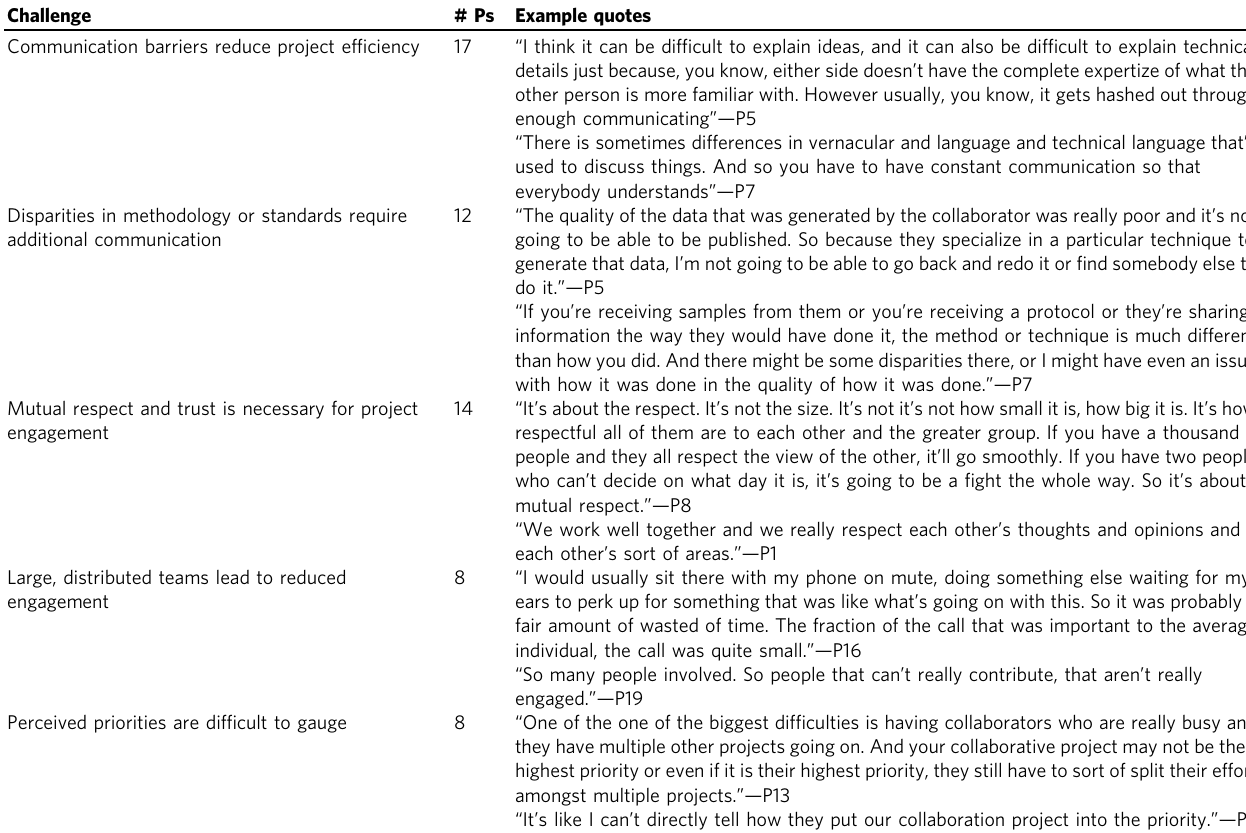
Table 2 Overview of major fi ndings with example quotes from each